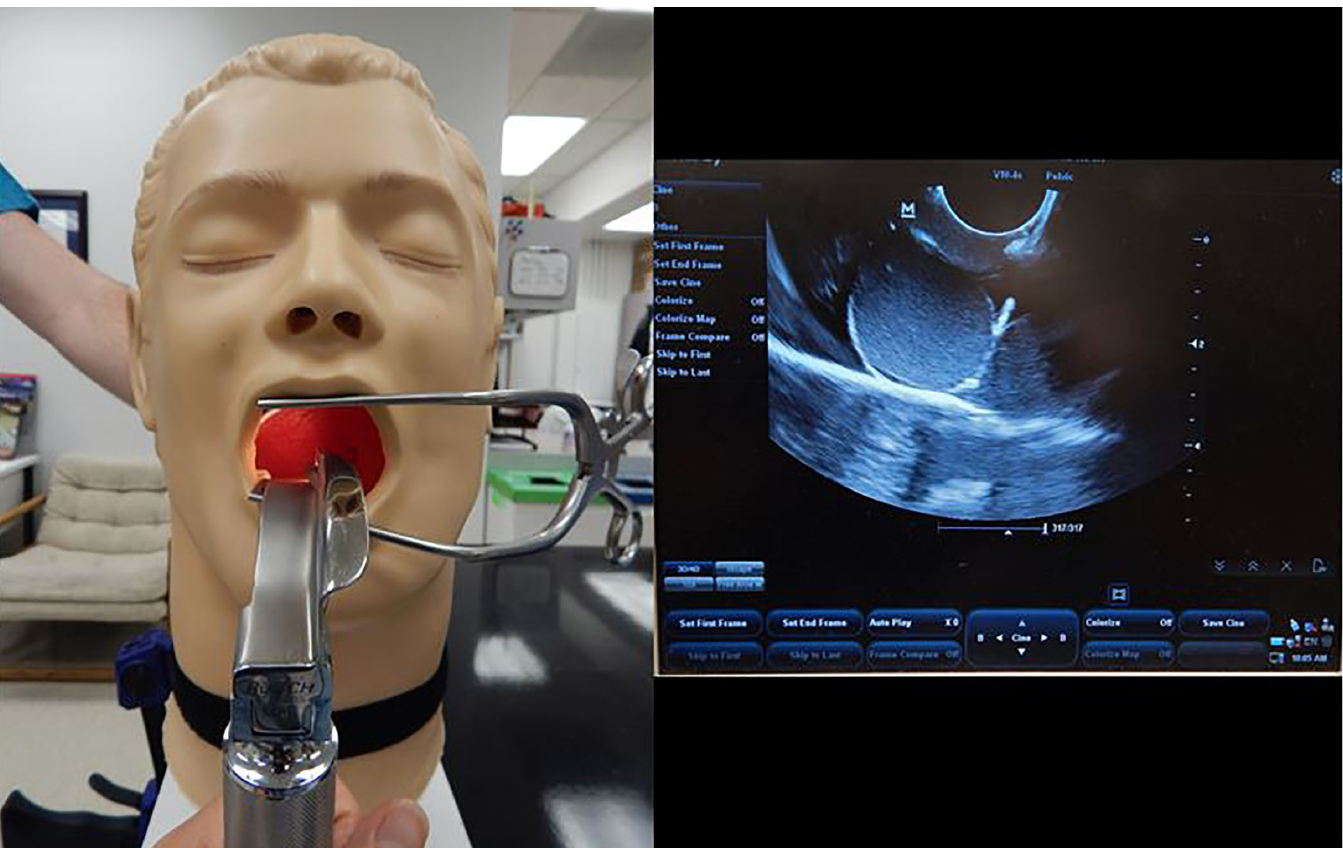
Figure 2. Completed ultrasound-guided peritonsillar abscess task trainer and corresponding ultrasound